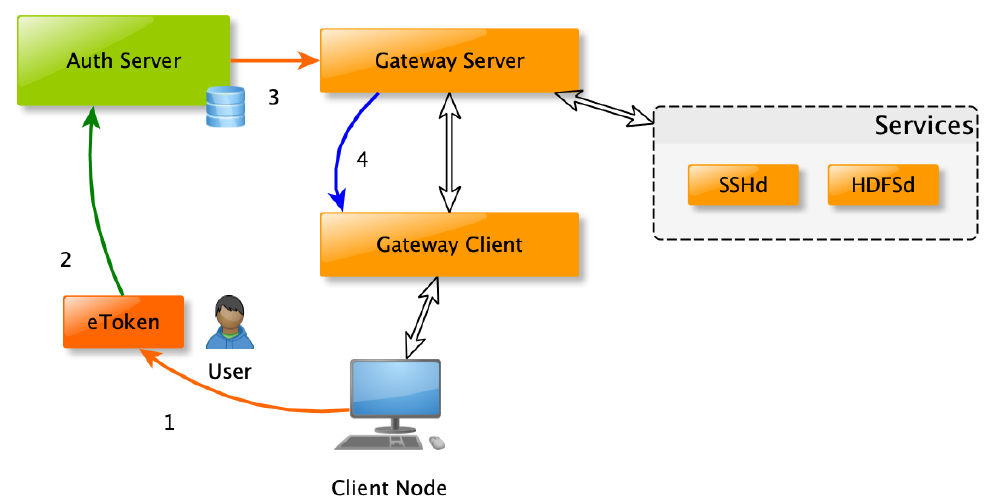
Figure 1. Main elements of the authentication and communication system.